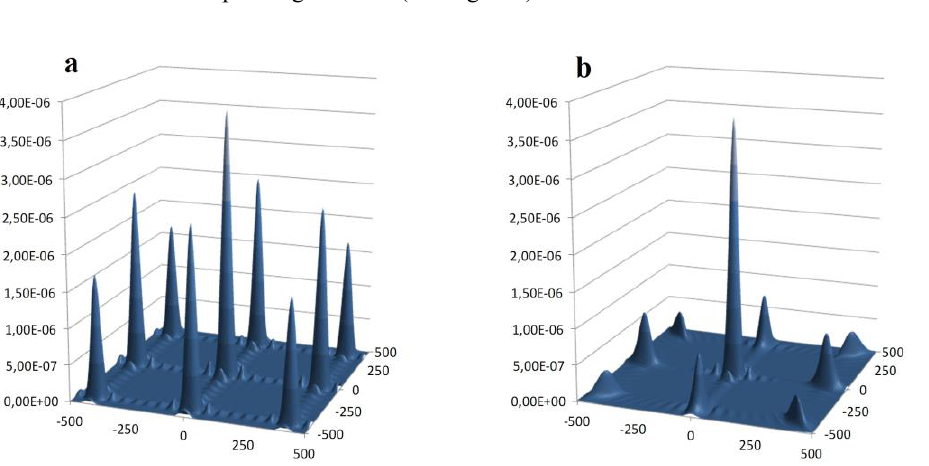
Fig. 3. Directivity patterns D f (x) and D(x) of 8x8 array for CW signal (a) and for short pulses (b)